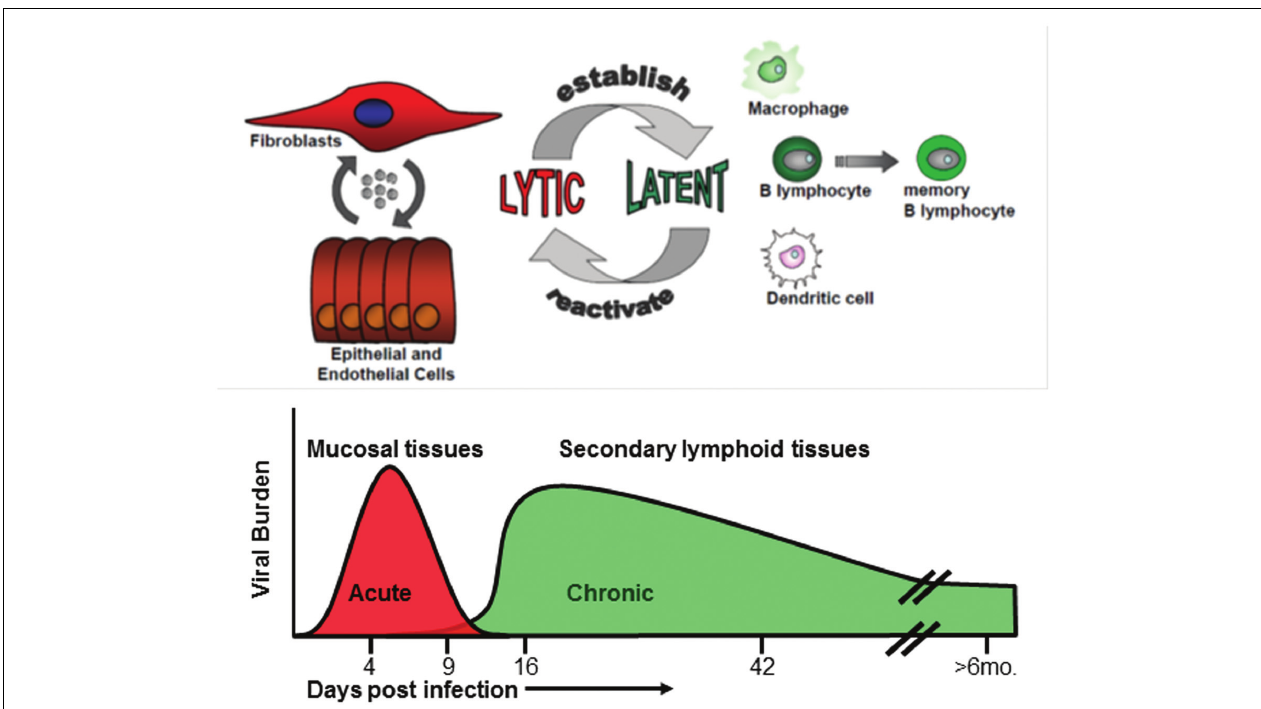
FIGURE 1 | Course of an MHV68 infection in mice. Acute lytic replication occurs in the lung (intranasal infection) or in the spleen (intraperitoneal infection). Ongoing replication is cleared typically by 12 days. The peak of latency is measured around 16 days post-infection in secondary lymphoid tissues such as the spleen. Maintenance of latency is typically evaluated 42 days post-infection. B cells are the predominant latency reservoir, followed by macrophages, dendritic cells, and endothelial cells. Lymphomas arise at late stages in immunocompromised